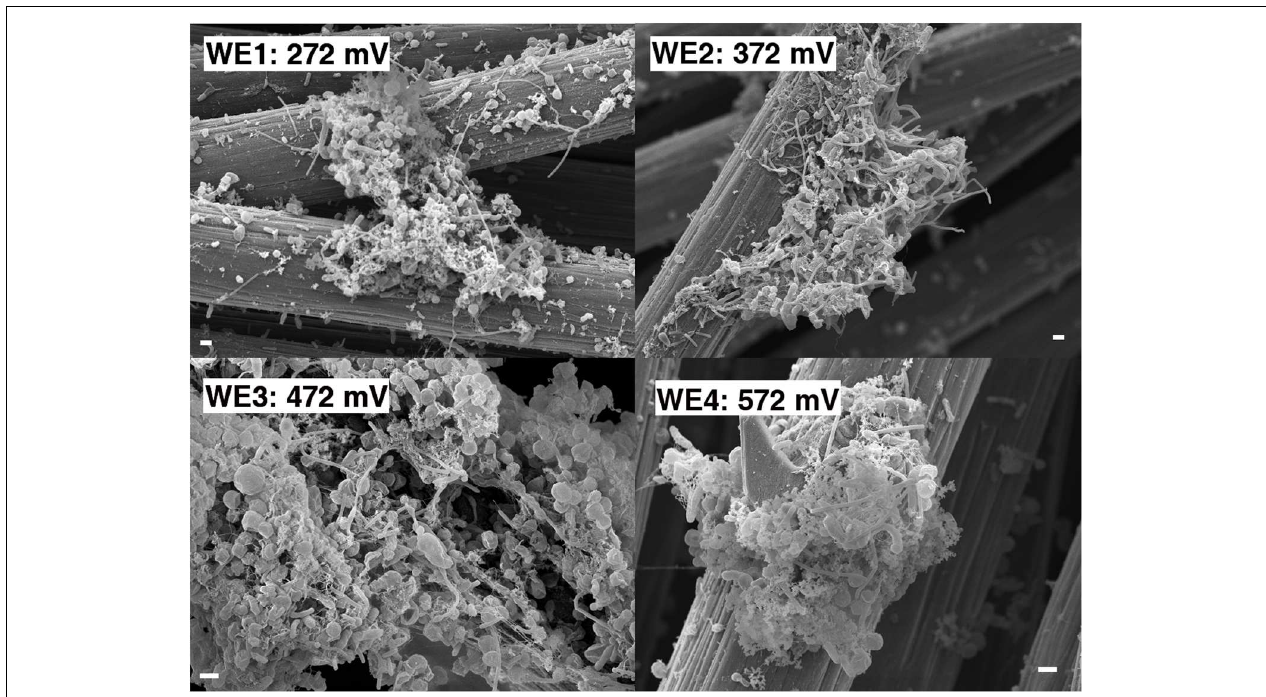
FIGURE 3 | Scanning electron microscopy of the enrichment electrodes and associated biomass (1 µ m scale